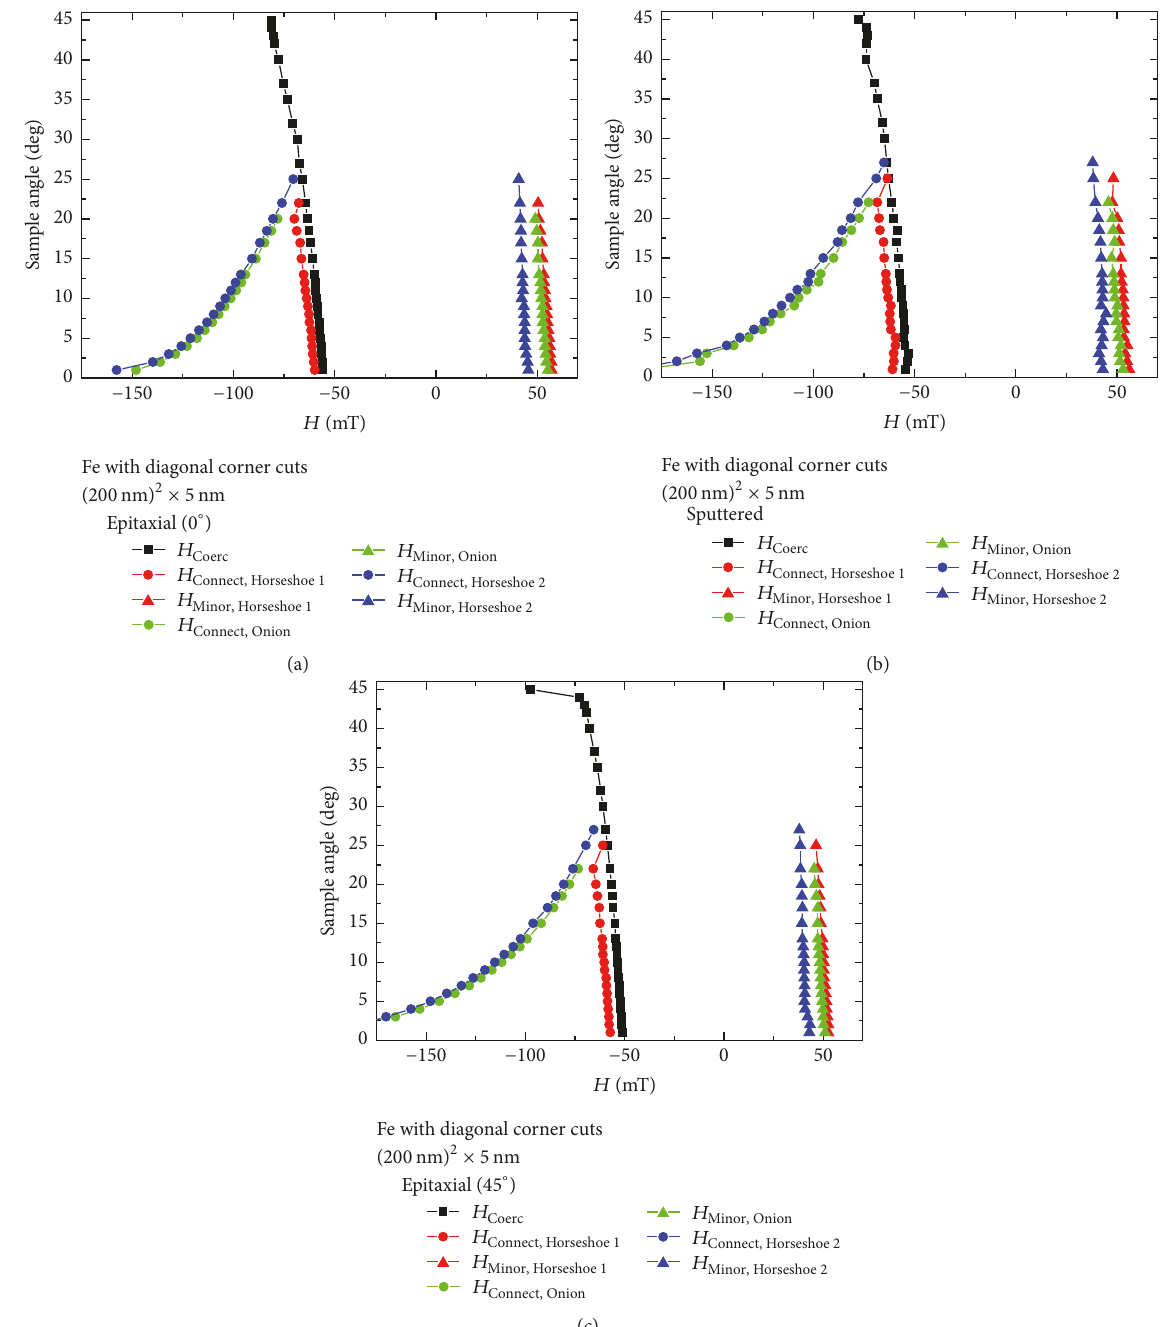
Figure 7: Phase diagrams simulated for nanorings with diagonal corner cuts, assuming epitaxial anisotropy orientation along 0 ∘ (a), 45 ∘ (c), and random anisotropy axes (b). The colors of the texts correspond to those in Figure 5; dot colors are identical with those in Figure